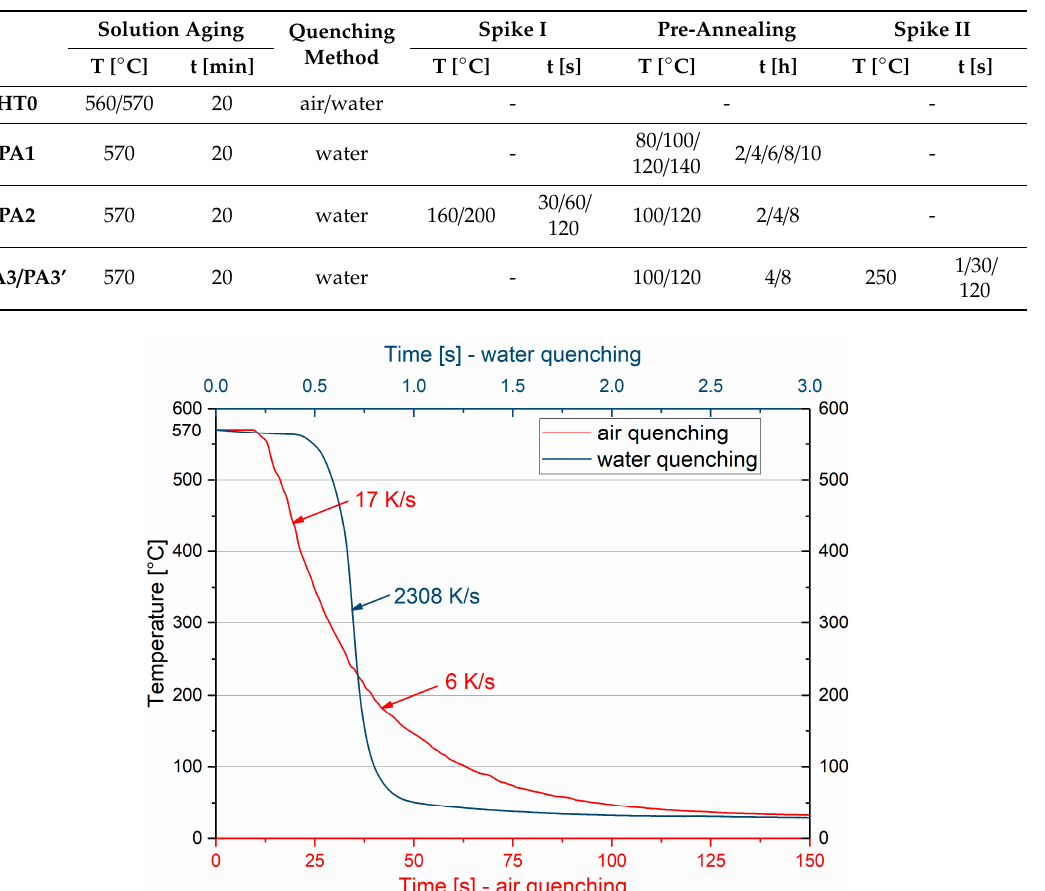
Figure 2. Cooling rate from 570 ◦ C of 1-mm thick aluminum sheets with air or water Table 2. Detailed overview of each heat treatment.